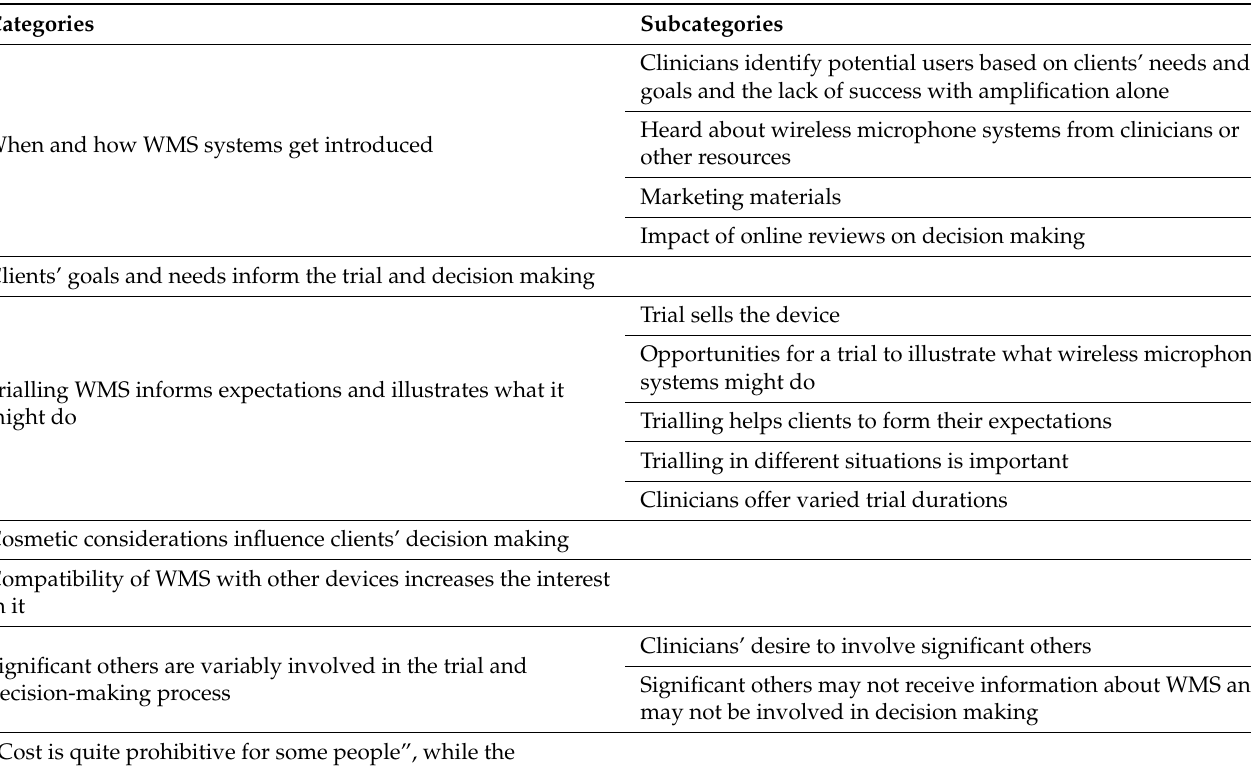
Table 3. Theme 2. The trial and decision-making process is